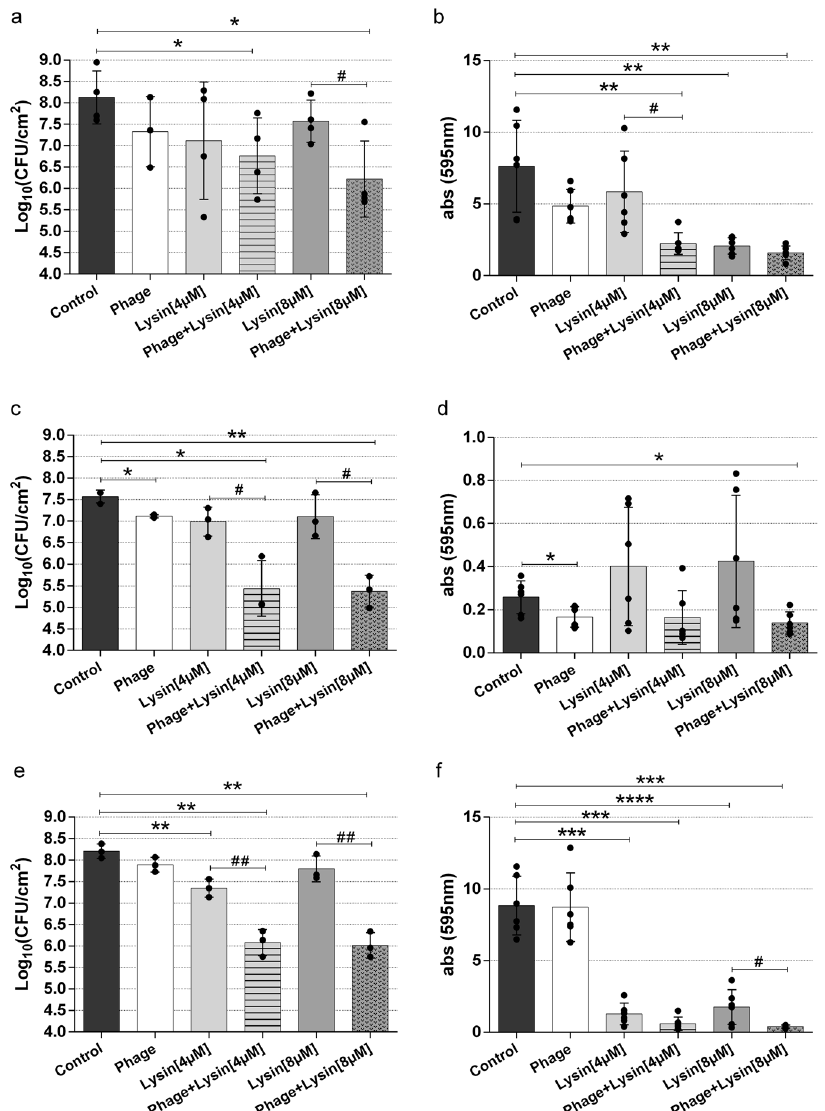
Fig. 1 Treatment of preformed bio fi lms formed by different S. aureus strains. Bio fi lms formed by S. aureus 15981 ( a and b ), IPLA1 ( c and d ), and V329 ( e and f ) were treated with bacteriophage phiIPLA-RODI (10 10 PFU/ml) (white bars), chimeric protein CHAPSH3b (4 and 8 µM) (light gray and dark gray bars, respectively) or the combination of both antimicrobials (striped and dotted bars). Bio fi lms were allowed to develop for 24 h and then treated for another 24 h at 37 °C. TSB medium alone was added to the control wells (black bars). After incubation, the viable cell counts of the three strains were determined ( a , c and e ) and the adhered biomass was quanti fi ed (A 595 ) by crystal violet staining ( b , d , and f ). Data represent the means ± standard deviations of three independent experiments. Bars with an asterisk are statistically different from the untreated control, and bars with a hash sign are statistically different from the treatment with CHAPSH3b alone at the same concentration, according to the unpaired t -test with Welch ’ s correction. * /# p -value < 0.05, ** /## p -value < 0.01, *** /### p -value < 0.001 and **** /#### p -value